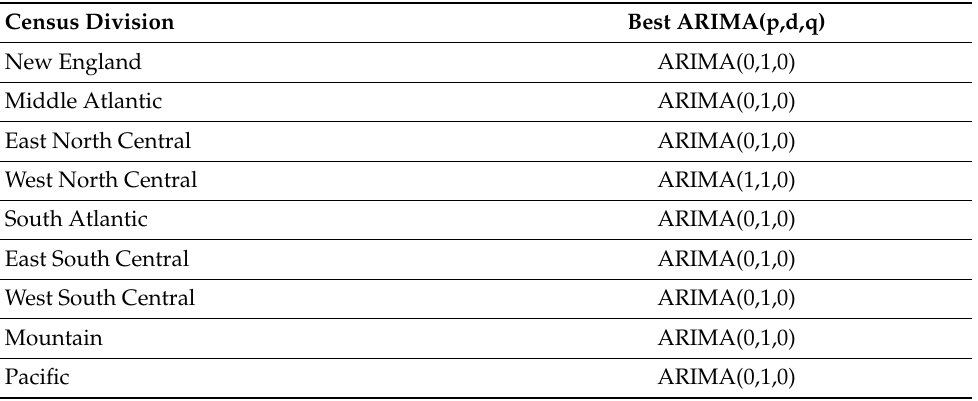
Table 4. Best ARIMA(p,d,q) for